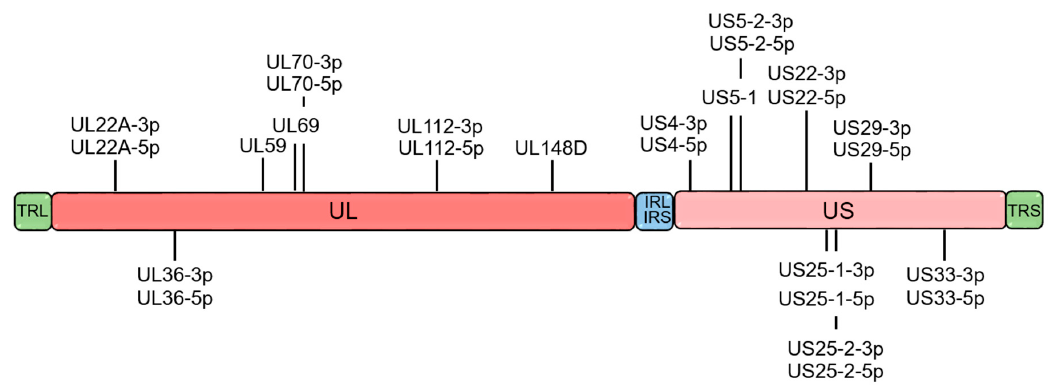
Figure 1. Genomic organization of human cytomegalovirus (HCMV) microRNAs (miRNAs). Localization of mature miRNAs along the linear representation of the HCMV genome divided into unique long (UL) and unique short (US) regions. These regions are flanked by terminal and internal inverted repeats (TRL, IRL, TRS, and IRS). Sense and antisense miRNA precursors are shown above and below the viral genome, respectively.